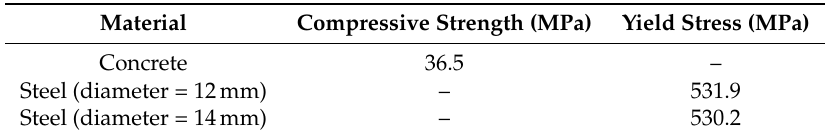
Table 2. Stiffness and strength properties of concrete (age = 28days) and steel at room